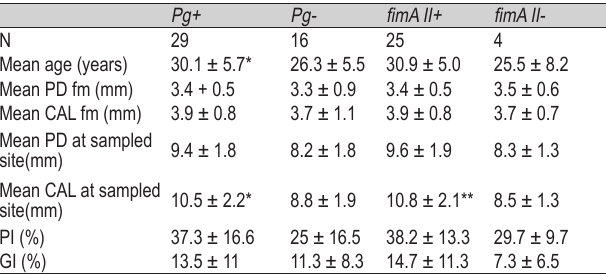
Table 2 - Characteristics of the patients according to the presence/ absence of the microorganism/genotype